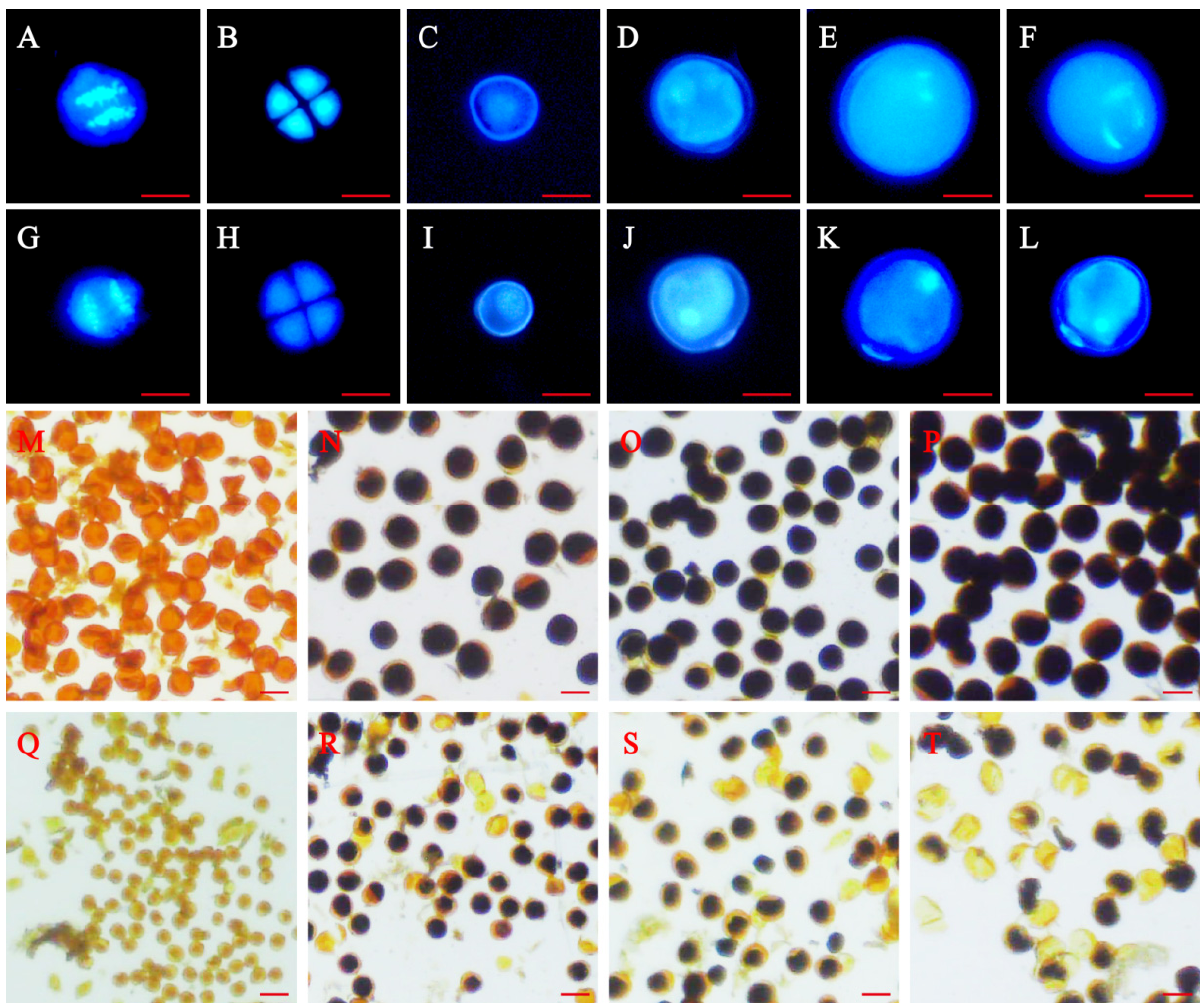
Figure 2. DAPI- and I 2 –KI-stained samples showing microspore development of the wheat YS9 and B lines. Different stages of microspore development in the YS9 ( A – F , M – P ) and the corresponding stages of the B ( G – L , Q – T ) were compared. ( A , G ) Dyad stage; ( B , H ) tetrad stage; ( C , I , M , Q ) early-uninucleate stage; ( D , J , N , R ) later-uninucleate stage; ( E , K , O , S ) binucleate stage; and ( F , L , P , T ) trinucleate stage. Scale bars are 50 µm.